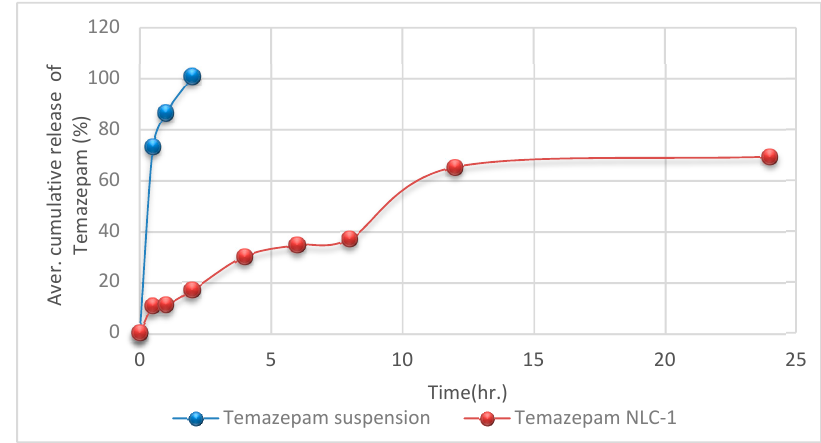
Figure 8. In vitro release profile of temazepam NLC-1 formulation compared to temazepam suspension in phosphate buffer saline (PBS, pH 7.4) at 37 °C. Data are expressed as mean ± S.D. ( n = 3).